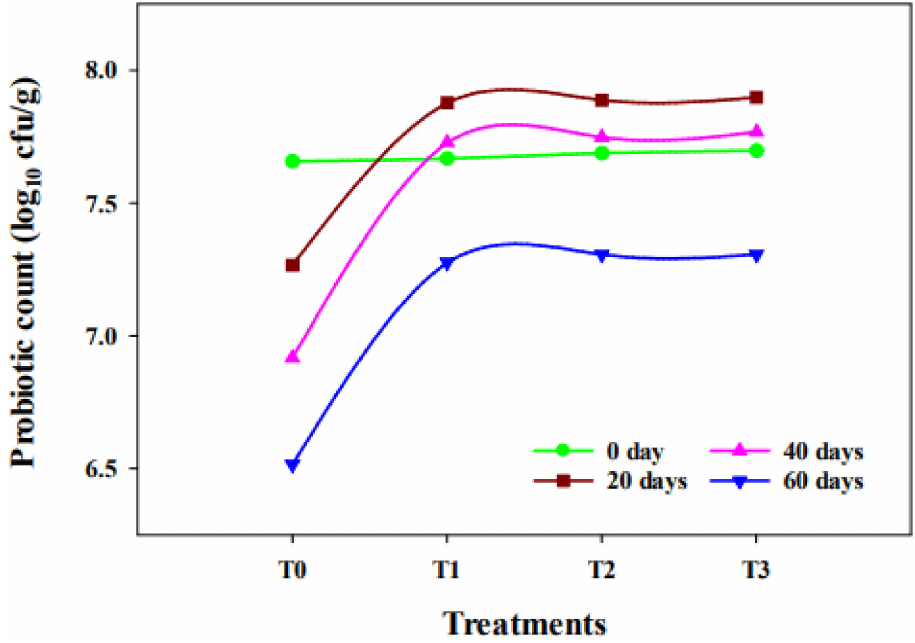
Figure 4. Effect of treatment and ripening on viable probiotic